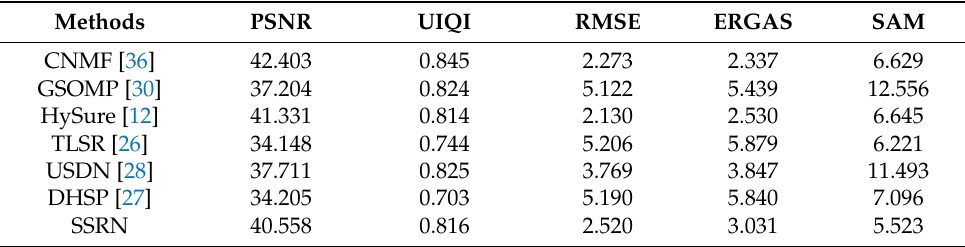
Table 10. Quantitative experimental results on the CAVE